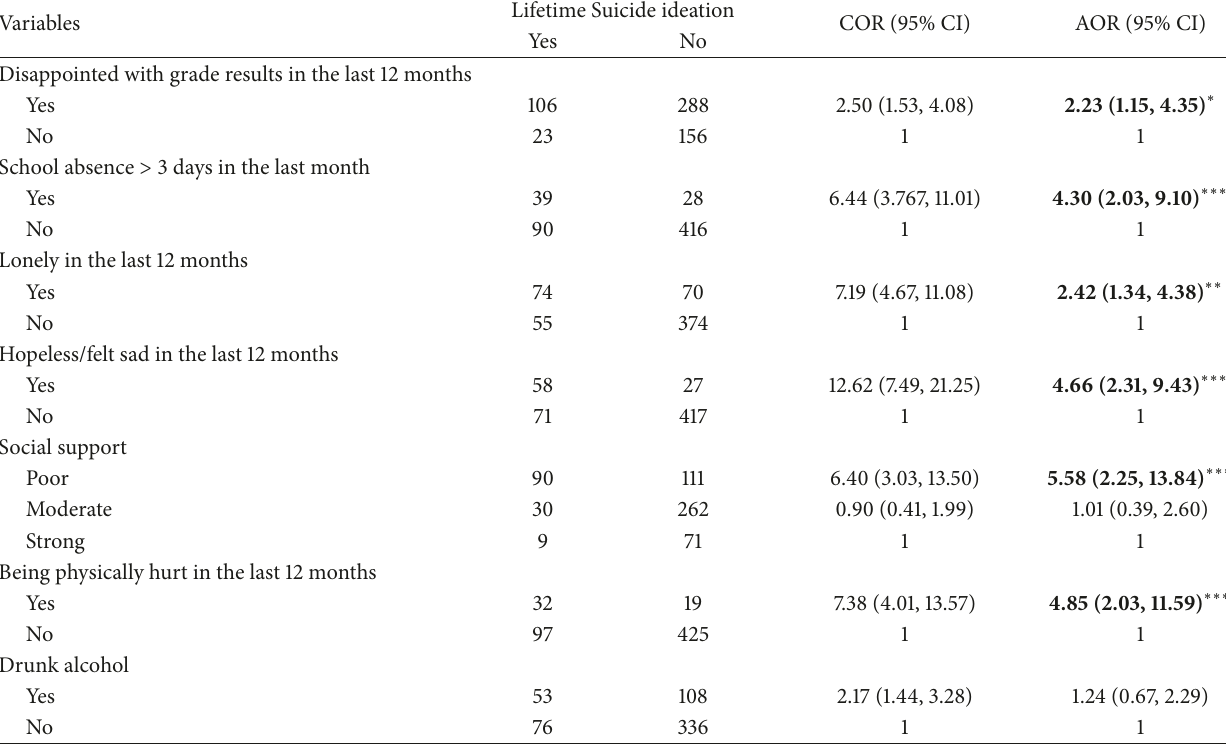
Table 5: The bivariable and multivariate logistic regression analysis results of suicide ideation and associated factors among adolescent high school students in Dangila Town, Northwest Ethiopia, 2015.